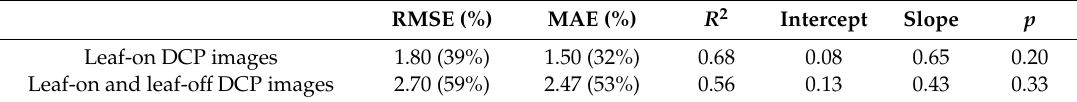
Table 9. Correlation statistics between litter collection LAI and LAI derived from DCP using two calculation schemes (two-tailed Student’s t -test with 95% confidence level). The RMSE and MAE are expressed in LAI units (m 2 / m 2 ). RMSE (%) MAE